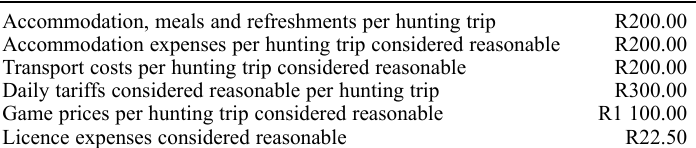
Table 7 Biltong hunting